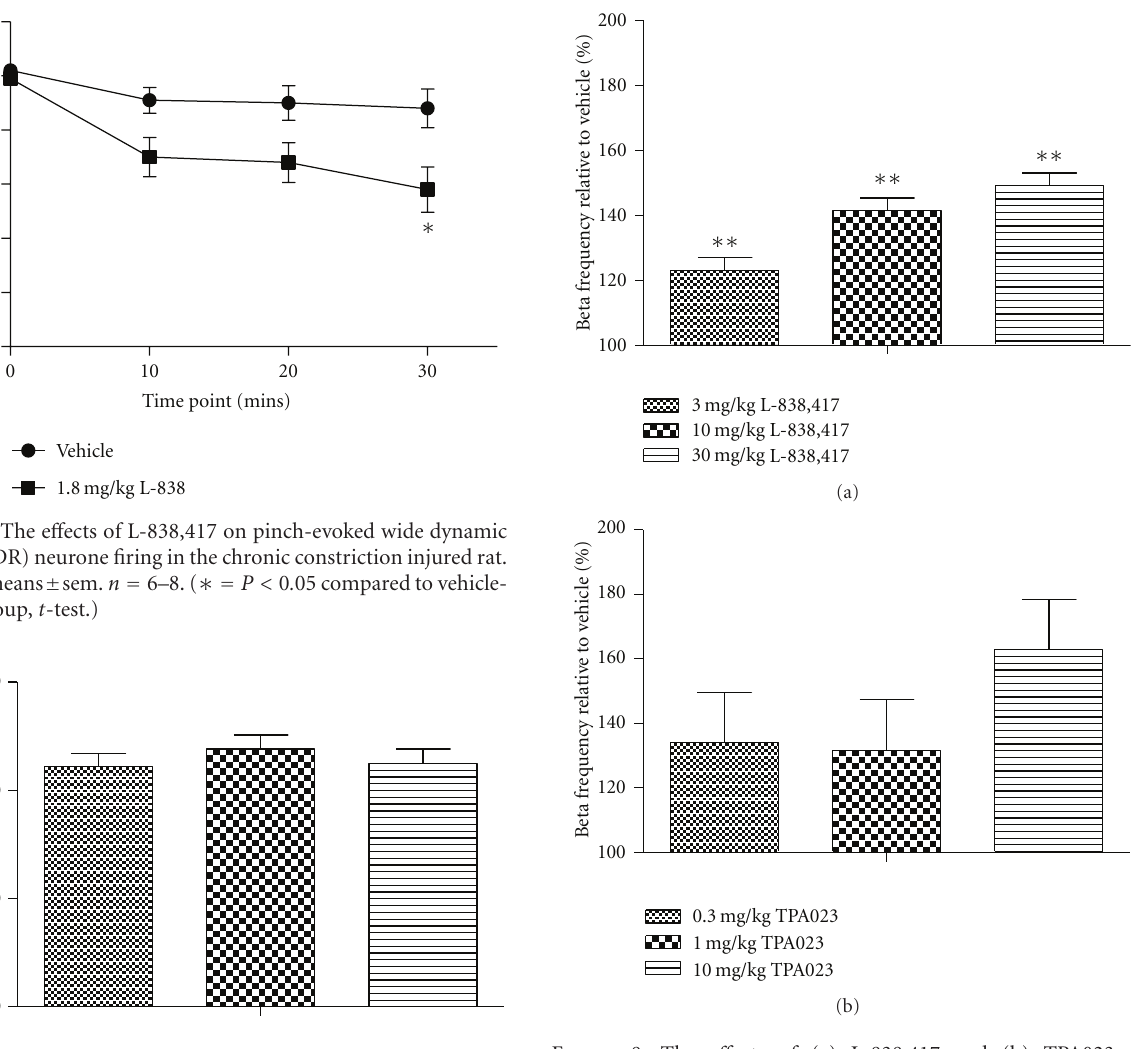
Figure 8: The e ff ects of (a) L-838,417 and (b) TPA023 on quantitative electroencephalogram (EEG) in the telemetered rat. Data are expressed as the total power in the beta frequency of the EEG signal over a four-hour period, as a percentage of vehicle control. Data are means ± sed. n = 6. Studies were four-period crossovers, and therefore means and SED’s are adjusted for period and rat e ff ects. ∗∗ = P < 0 . 01 compared to vehicle-treated group. Restricted maximum likelihood (REML) analysis, followed by Fisher’s post hoc